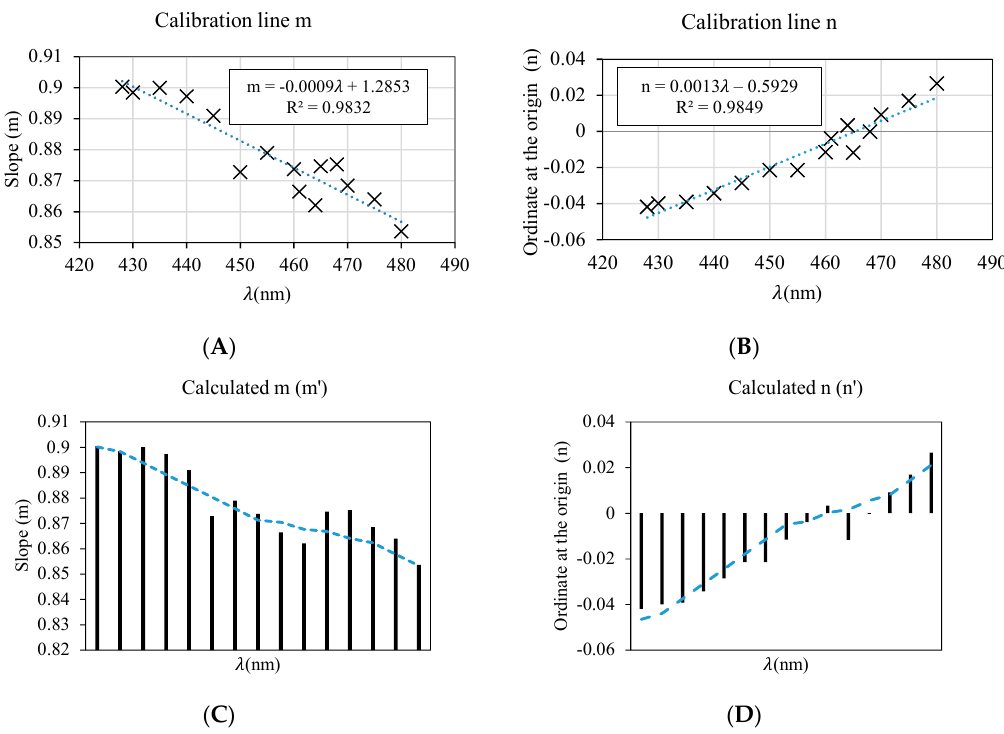
Figure 19. Calculation of the trend lines of the slope m and the ordinate at origin n according to λ . ( A , B ) are the scatter graphs used to enable the regression line (model) for the slope m and the ordinate at origin n to be calculated. ( C , D ) show the m and n values calculated through that model.